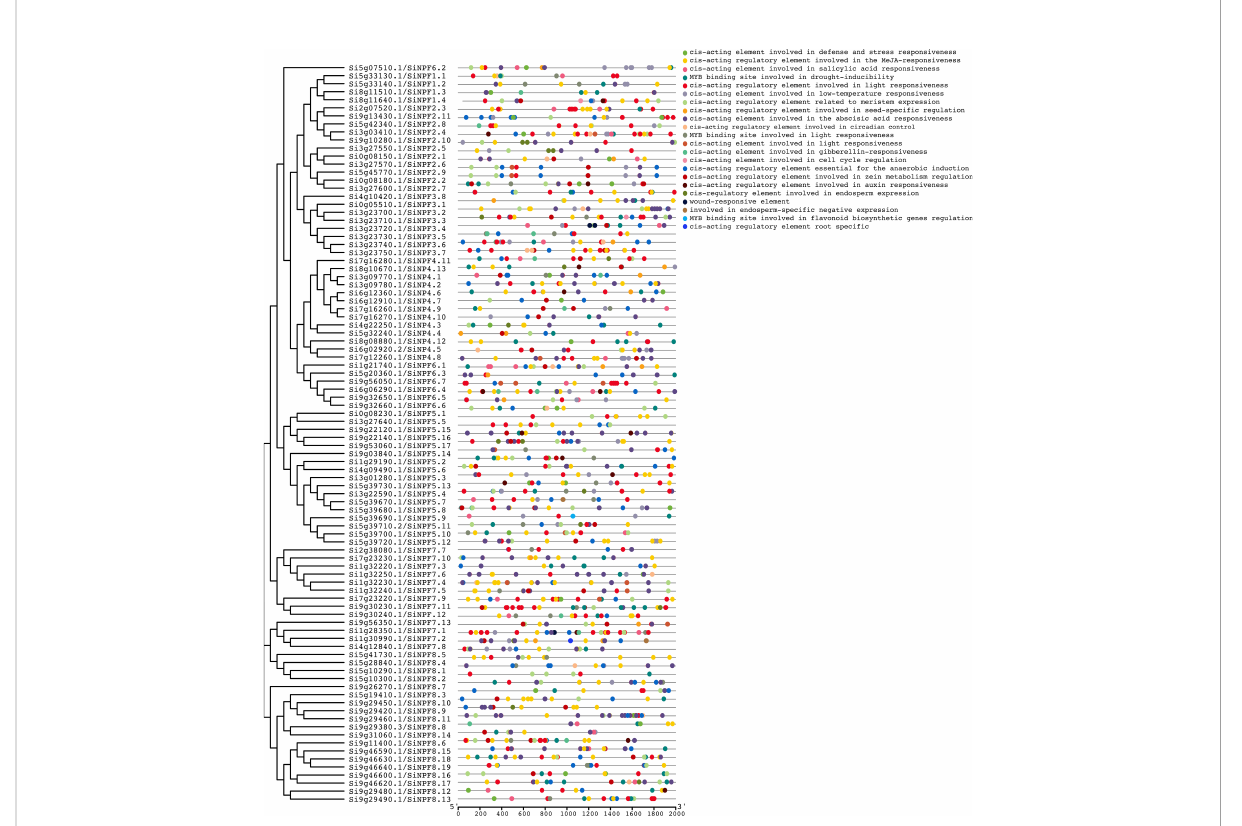
FIGURE 4 cis -acting regulatory elements in the SiNPF promoters. Different colored circles represent different types of